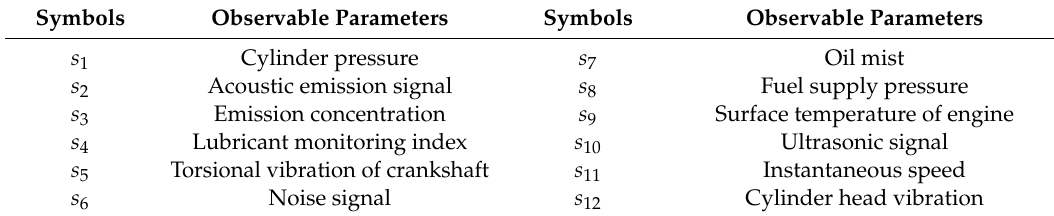
Table 2. The observable parameters of a diesel